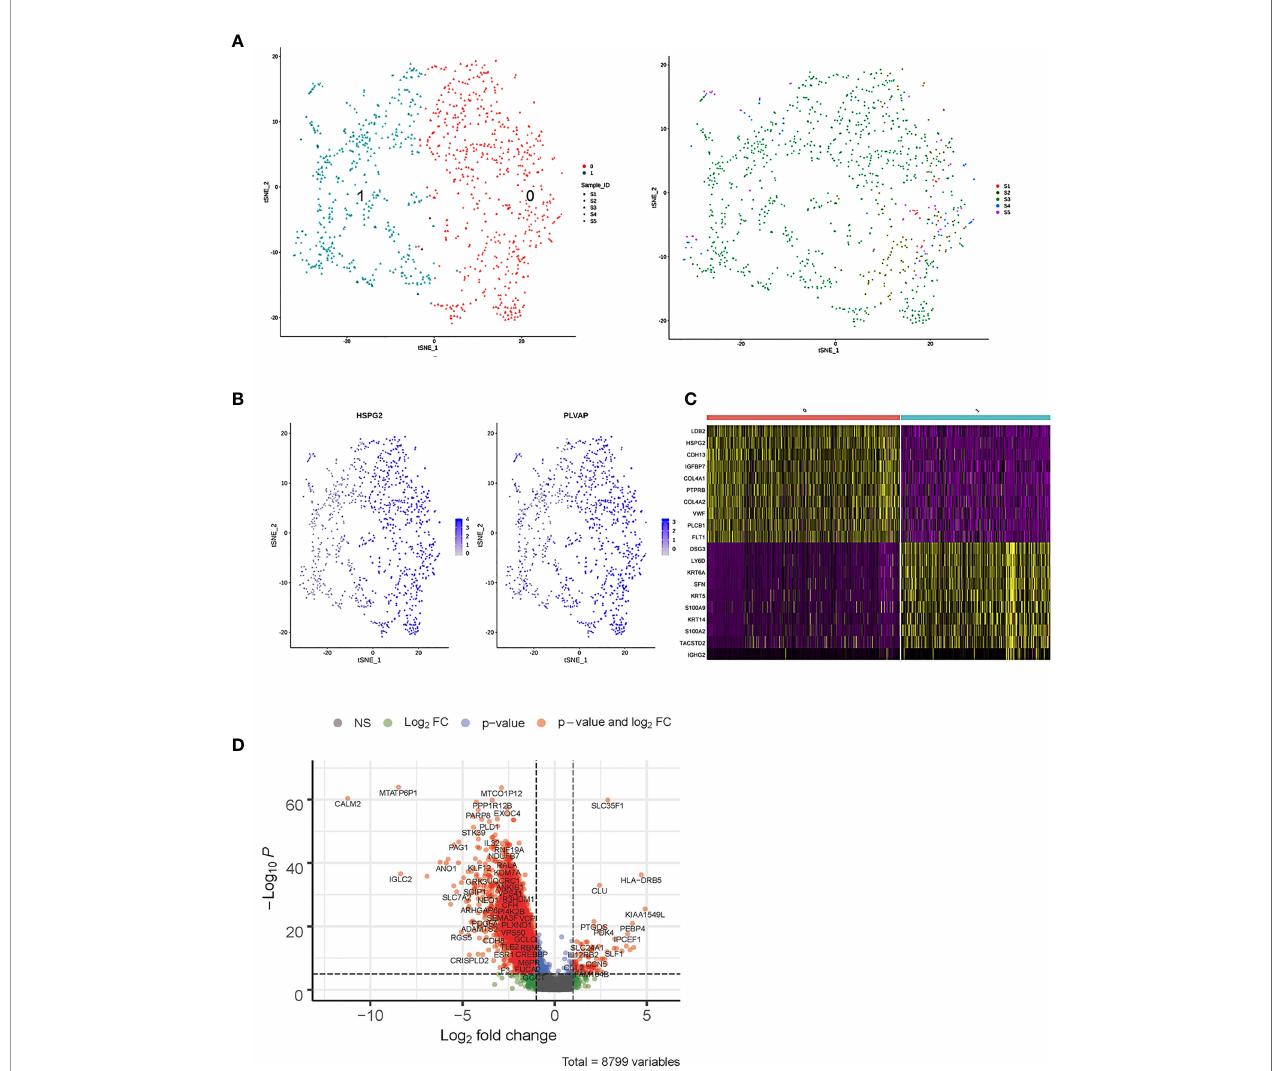
FIGURE 5 | Single-cell RNA sequencing (scRNA) pro fi les of endothelial cell (EC) lineages. (A) Reclustering of 1,037 fi broblast cells, color-coded by clusters (left) or sample origin (right). (B) t -Distributed stochastic neighbor embedding ( t- SNE) plot color-coded for marker gene expression (gray to white to blue) of HPSG2 and PLVAP . (C) Heatmap shows differentially expressed marker genes (rows) in two clusters. Yellow and dark purple: high and low expression, respectively. (D) Volcano plot shows differentially expressed marker genes between cervicitis and cervical cancer